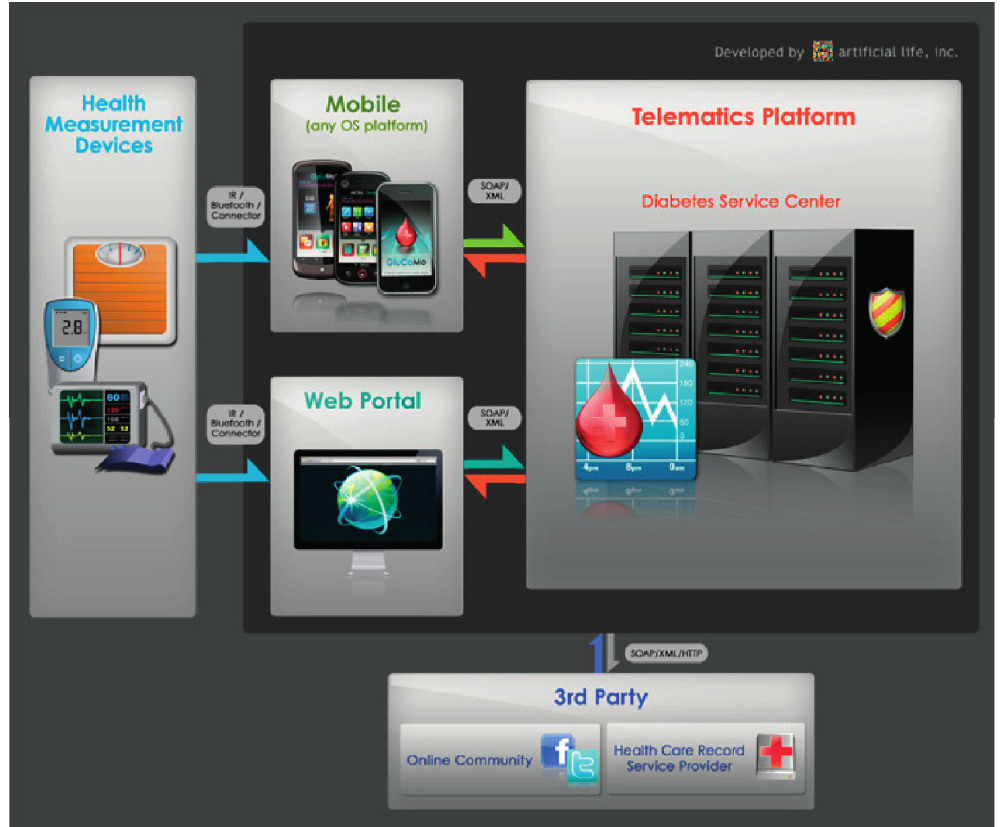
Figure 9. GluCoMo™ developed by Artificial Life, Inc. Reproduced with permission from Ada Fong, Artificial Life,